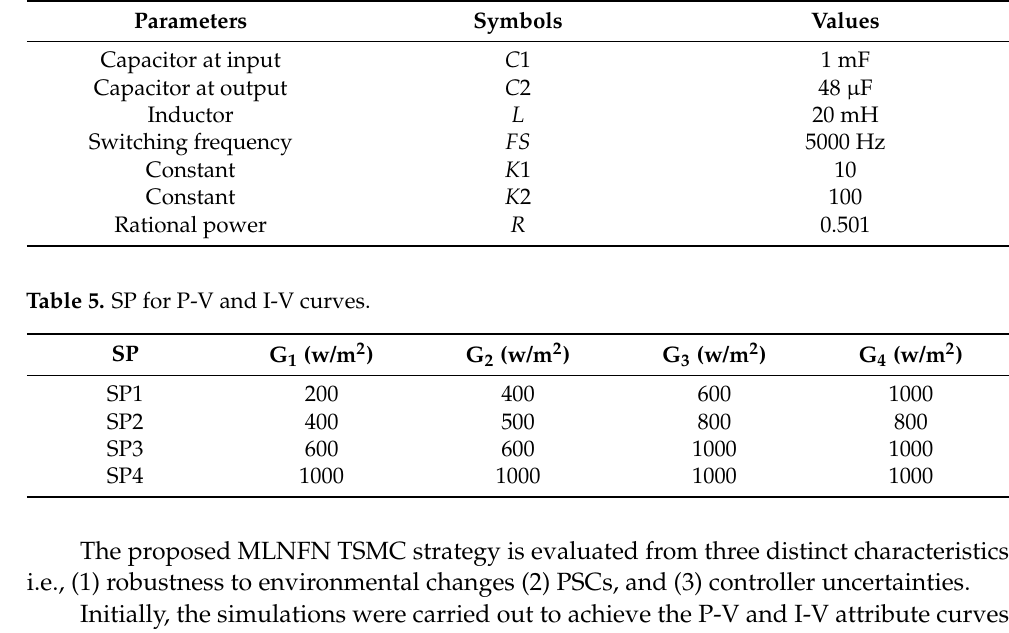
Table 4. Parameters of converter and controller.